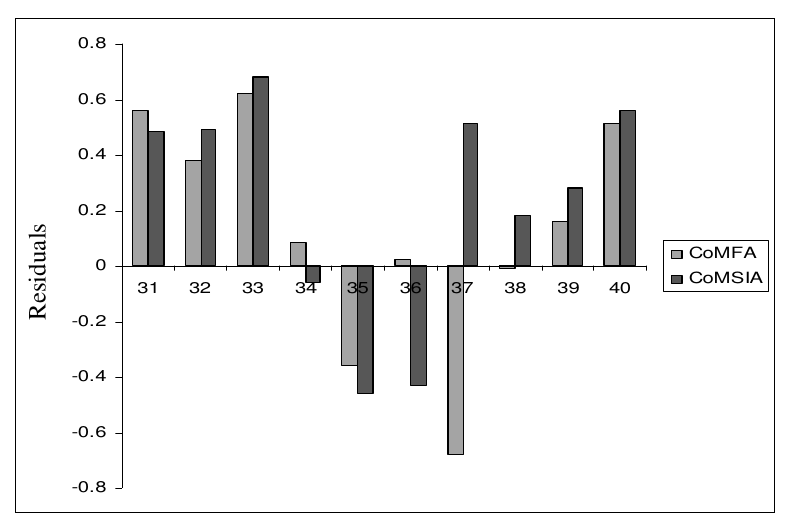
Figure 5. Histogram of test set molecules. Table 2 . Summary of CoMFA and CoMSIA